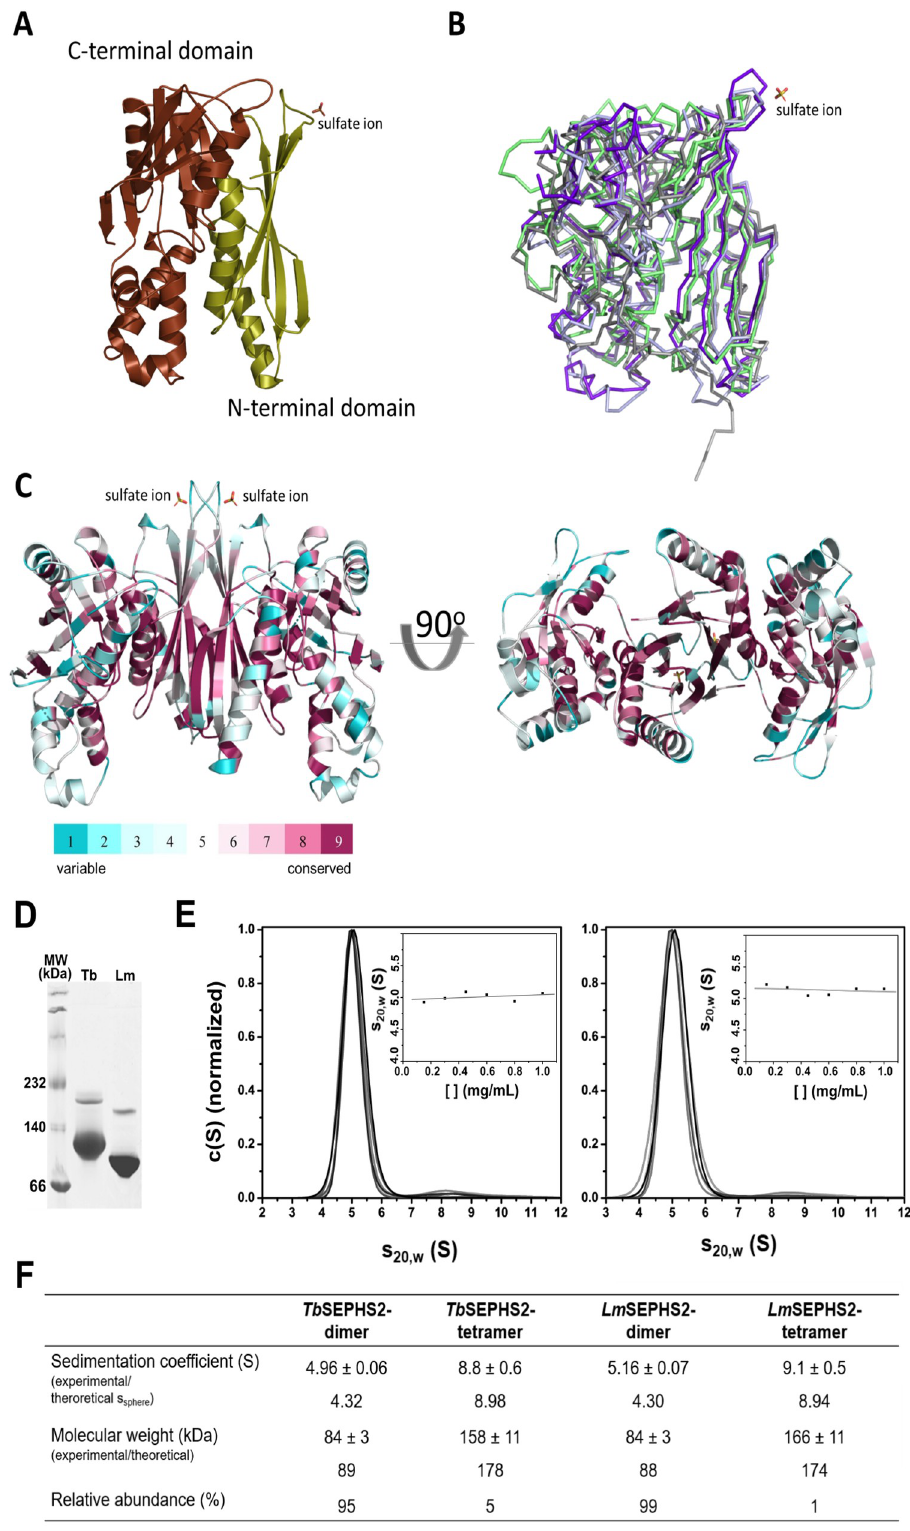
Fig 1. Δ N- Lm SEPHS2 crystal structure. A- Cartoon representation of the monomer structure in the asymmetric unit showing a typical AIRS-like folding. The sulfate ion is represented as sticks. B- Superimposition of Aa SEPHS (grey) [38], Ec SEPHS (green) [39], Hs SEPHS1 (light blue) [22] and Lm SEPHS2 (purple). C- Dimeric model generated using PDBePISA [40] depicting amino acid residue conservation. D- Native gel electrophoresis showing the prevalence